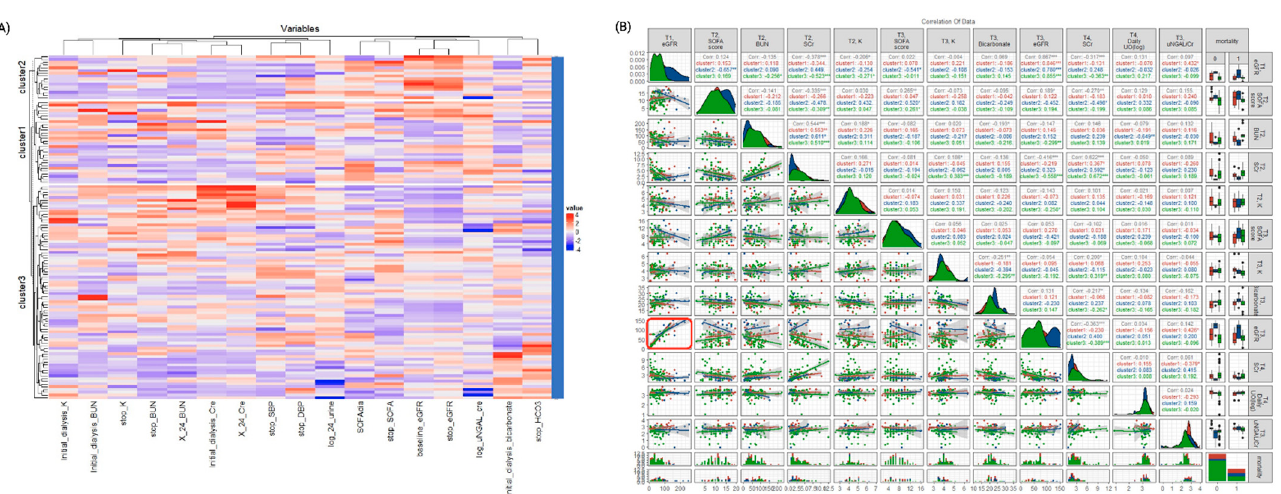
7 of 16 Figure 1. Consensus clustering analysis results displaying the robustness of sample classification using multiple iterations of k-means clustering. ( A – D ) The consensus matrix heat maps of K = 3, 4, 5 to K = 6 using 45 baseline parameters. The dark blue color shows the consensus of which groups fit perfectly together, and the white color shows that two individuals are always grouped separately. ( E ) Curve of CDF. ( F ) CDF delta area curve of consensus clustering. The x axis represents the cate- gory k, and the y axis denotes the relative change in area under the CDF curve of category k com- pared with category k − 1. Abbreviations: CDF, cumulative distribution function. 3.3. Clinical Characteristics of the Distinct Clusters Table 1 lists the characteristics of the three clusters. The clinical features differed sig- nificantly among the three clusters. However, there were no significant differences in age, gender, baseline eGFR, and the prevalence of diabetes, AKI due to shock, indication for